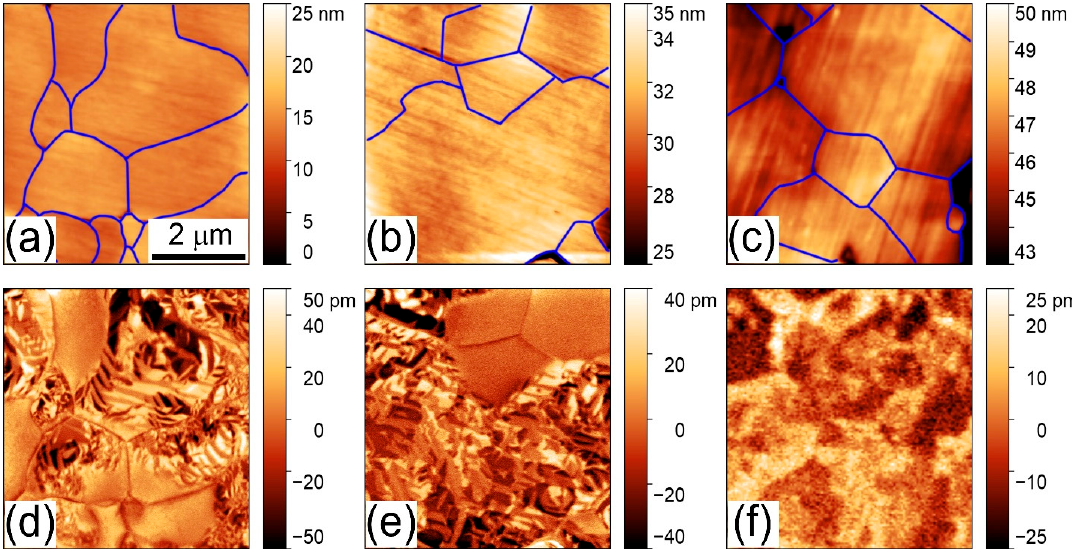
Figure 4. Topagraphy ( a , b , c , crystallines are marked by solid lines) and out-of-plane PFM images ( d , e , f ) of the compounds Bi 1 − x Ba x Fe 1 − x Ti x O 3 with x = 0.20 ( a , d ), 0.25 ( b , e ), 0.27 ( c , f ).